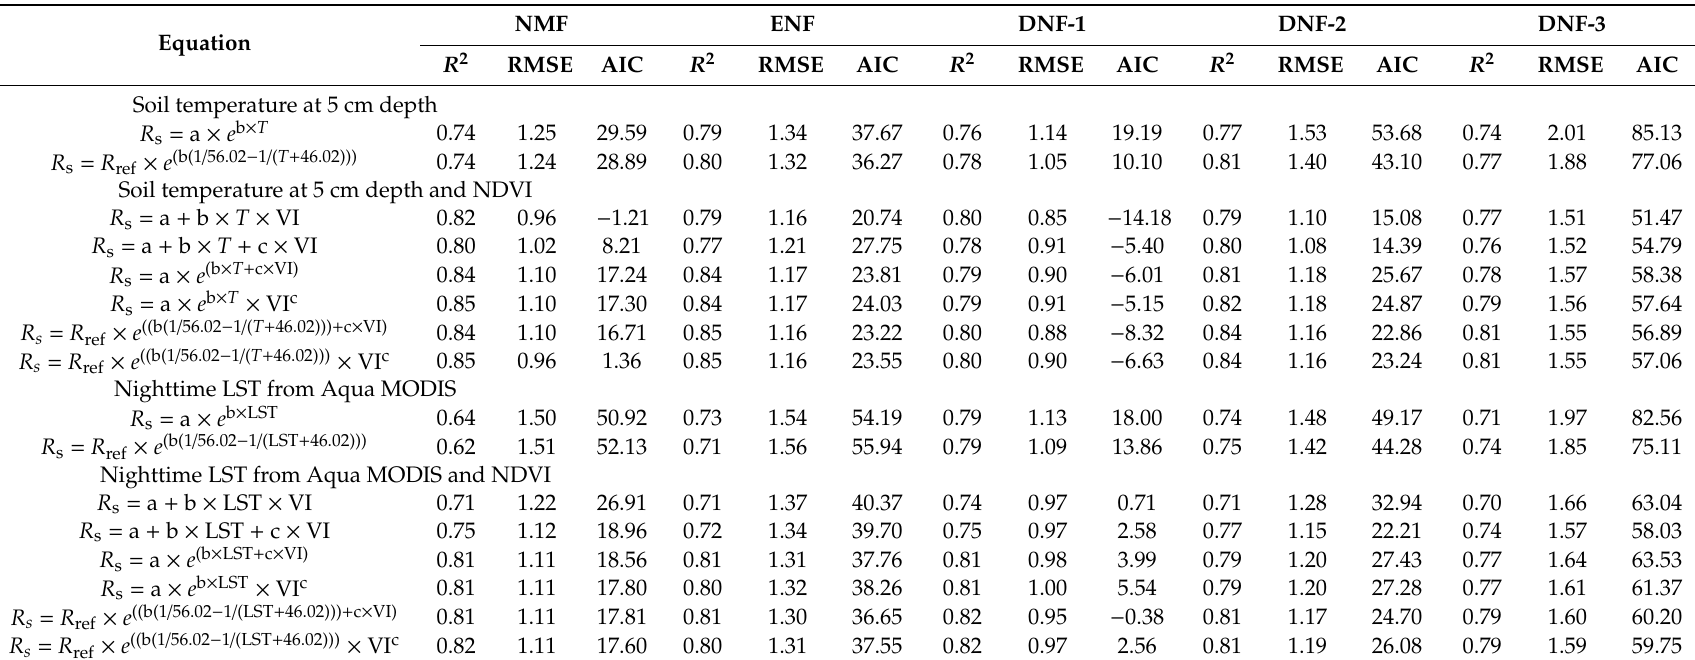
Table 7. Fitting statistics for the respiration models at the five sites for all measured data from during the measurement.